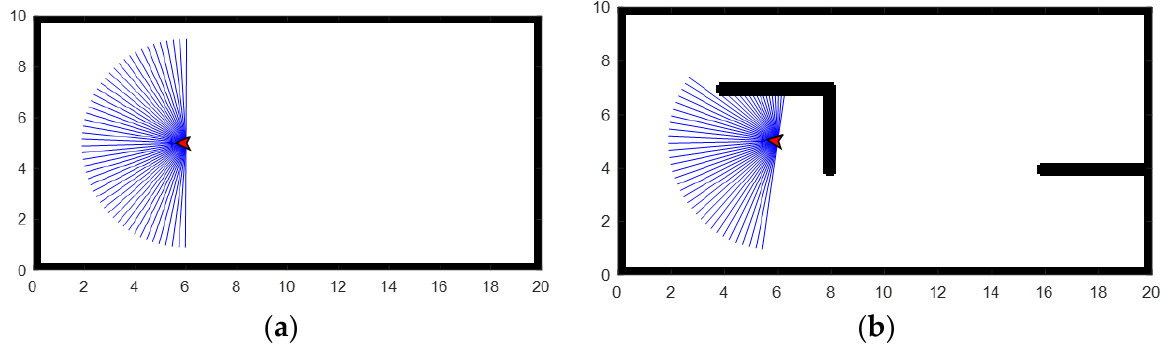
Figure 9. The environments of 20 × 15 m size for the two experiments: ( a ) simple environment, ( b )